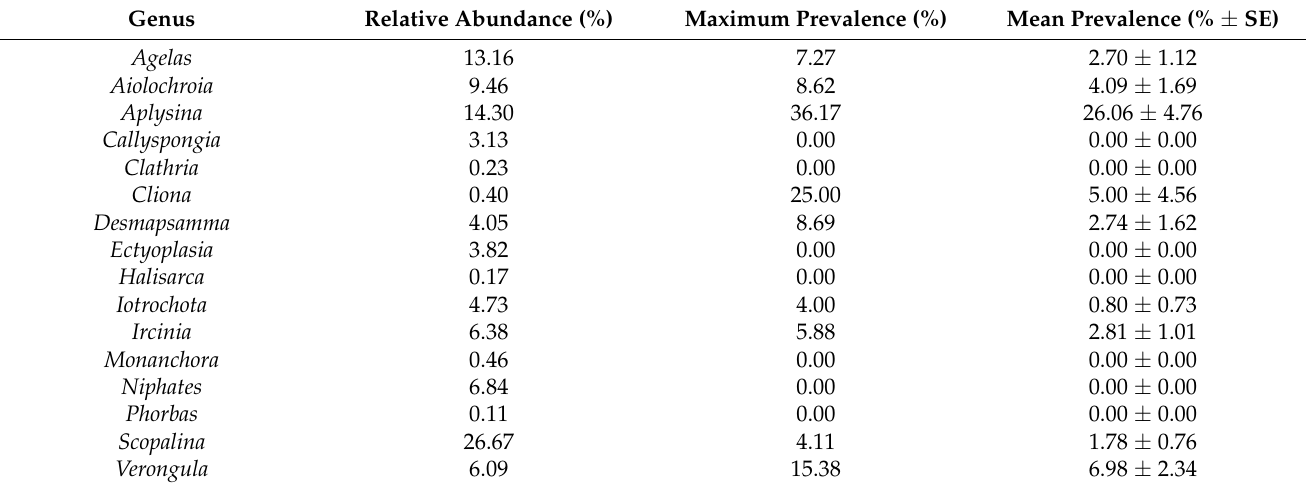
Table 2. Genera of sponges considered for the analyses in the study area with values of relative abundance, maximum and mean prevalence of association with Nemalecium lighti